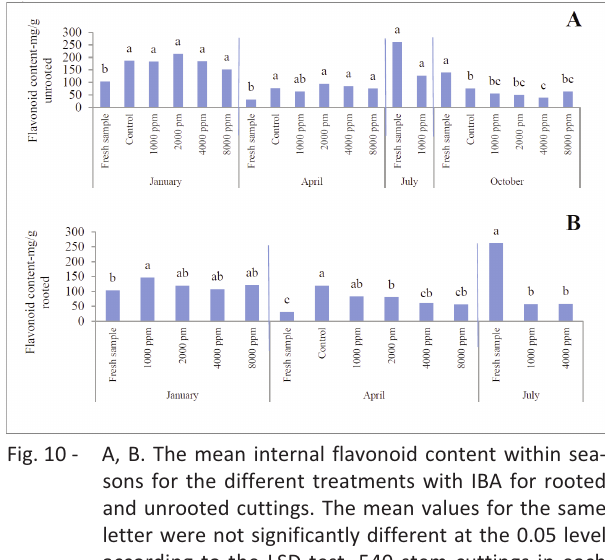
Fig. 10 ­ A, B. The mean internal flavonoid content within sea­ sons for the different treatments with IBA for rooted and unrooted cuttings. The mean values for the same letter were not significantly different at the 0.05 level according to the LSD test. 540 stem cuttings in each season were planted. For treatments not represented in the figure, all the cuttings